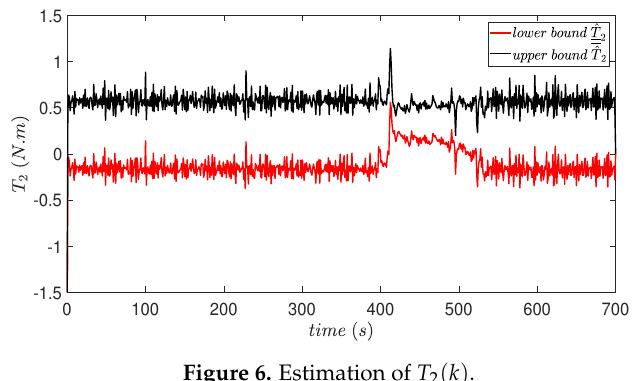
Figure 6. Estimation of T 2 ( k ) .